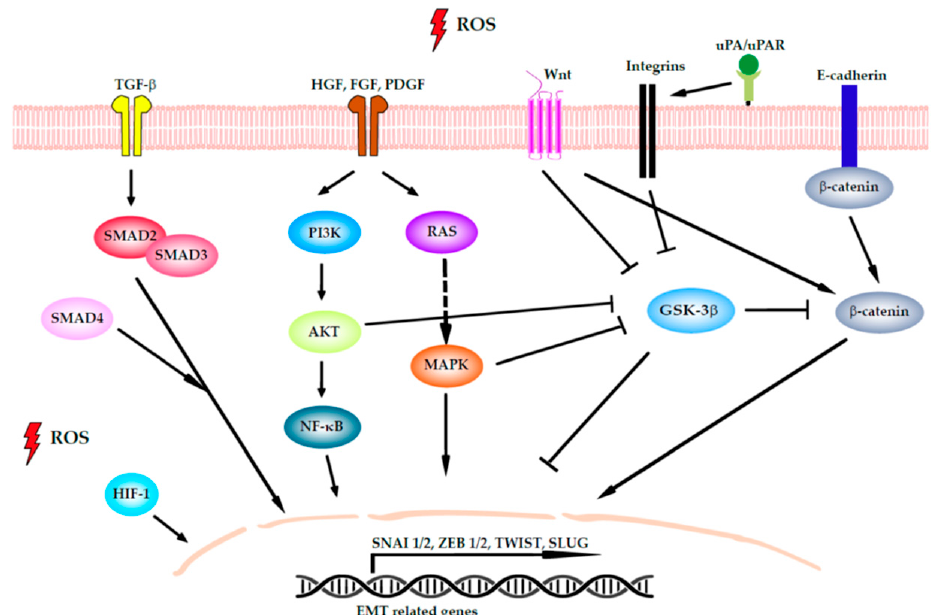
Figure 2. Signaling networks that regulate epithelial-to-mesenchymal transition (EMT) in colorectal cancer (CRC). The signaling pathways can induce EMT by the activation of the transcription factors (TFs) SNAI1/2, ZEB1/2, TWIST, and SLUG. Transforming growth factor β (TGF- β ) induces EMT by phosphorylation of Smad2 and Smad3, which localize to the nucleus with Smad4 to activate EMT TF. Wnt inhibits glycogen synthase kinase-3 (GSK3) to stabilize β -catenin. When β -catenin is active, it translocates to the nucleus to directly activate ZEB1 and SNAI1. Several growth factors that act through tyrosine kinase receptors, such as platelet-derived growth factor growth factor (PDGF), fibroblast growth factor (FGF), and hepatocyte growth factor (HGF), promote EMT through the RAS/mitogen-activated protein kinase (MAPK) signaling cascade, the phosphatidylinositol 3-kinase (PI3K)/protein kinase B (Akt) axis, and nuclear factor- κ B (NF- κ B). Both pathways inhibit GSK3 as well as integrin activation, thus cooperating with Wnt signaling. The urokinase plasminogen activator (uPA) bonds to its specific cellular receptor (uPAR) to concentrate proteolytic activity at the cell surface, with this being important for extracellular matrix remodeling. Finally, the E-cadherin present on cell surface binds to cadherins on adjacent cells, whereas its intracellular region contains binding sites to interact with catenins and other regulatory proteins. When the E-cadherin/ β -catenin complex is disrupted, it not only affects epithelial integrity but also the Wnt-signaling pathway. Hypoxia-inducible factor 1 (HIF-1) is activated by intracellular ROS and modulates EMT TF